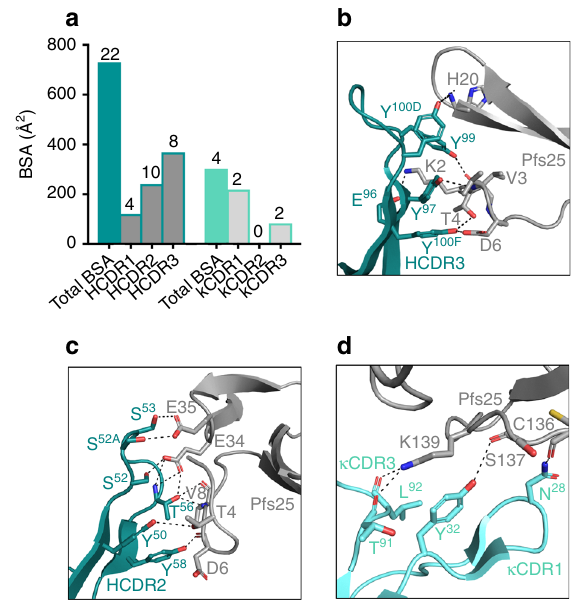
Fig. 4 Molecular de fi nition of the interaction between mAb 2544 and Pfs25. a Plot of buried surface area (BSA) of the 2544-Pfs25 complex crystal structure. BSA is separated into total interaction of heavy chain (dark teal) and light chain (light teal). Chains are further delineated into the amount of BSA per CDR, as labeled. The total number of hydrogen bonds and salt bridges per chain and CDR is listed above each bar. b Interaction between the 2544 HCDR3 (dark teal) and Pfs25 (gray). Both proteins are displayed as cartoons, and the side chains or main chain of residues that form hydrogen bonds are displayed as sticks. Hydrogen bonds are denoted by black dashes. c Interactions between 2544 HCDR2 (dark teal) and Pfs25 (gray). d Interactions between 2544 κ CDR1/ κ CDR3 (light teal)